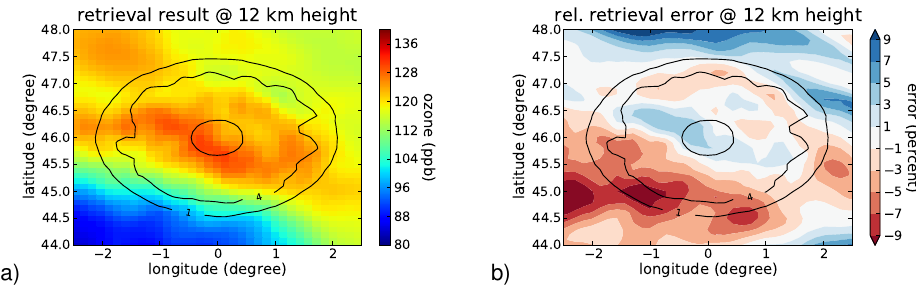
Fig. 18. The retrieval result of a run with advection and an averaged a priori wind speed knowledge. Panel (a) shows the retrieved ozone values at 12 km height while panel (b) depicts the relative error in percent compared to the true values. The number of tangent points within depicted volume elements is overlaid as a contour plot.